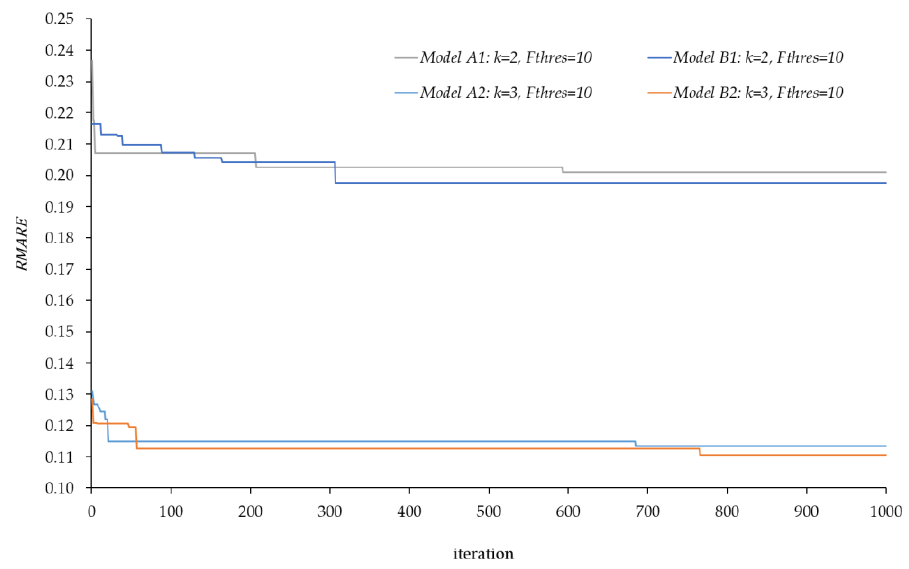
Figure 13. Evolution of RMARE value for the di ff erent cases varying the k parameter and the threshold flow.